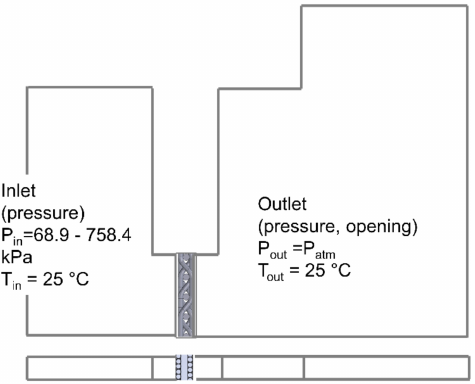
Figure 8. CFD model domain and boundary conditions for cross